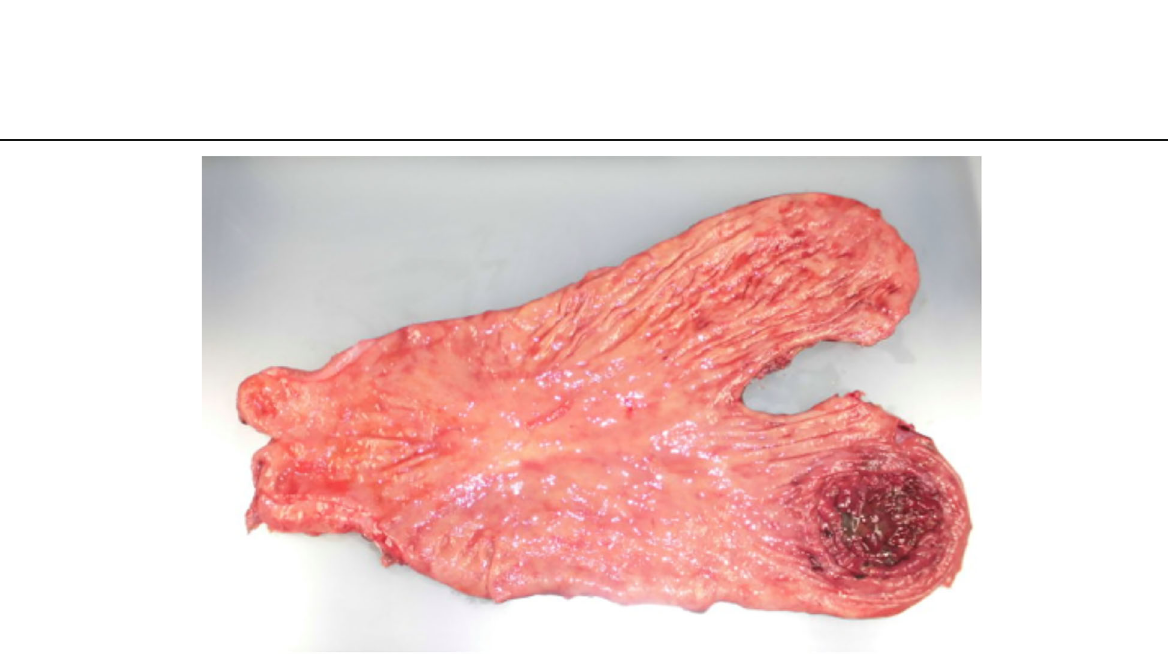
Fig. 3 Gross findings of specimen. The perforated area with ischemic necrosis was 7 × 4.5 cm in size at the posterior wall of the gastric fundus, which appeared very thin and dark